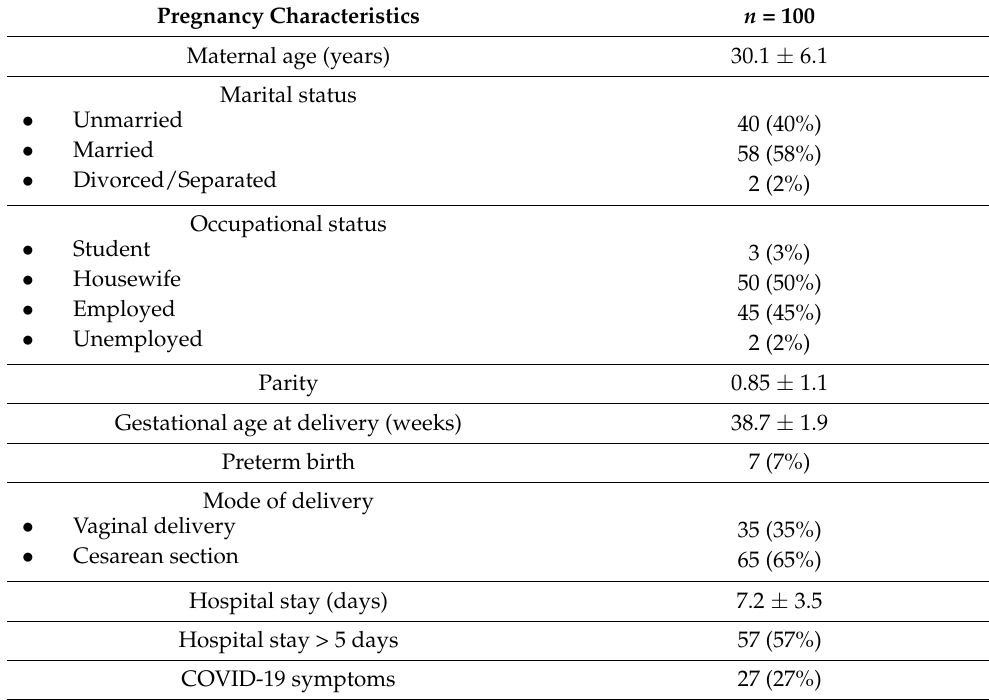
Table 1. Pregnancy characteristics of COVID-19 infected